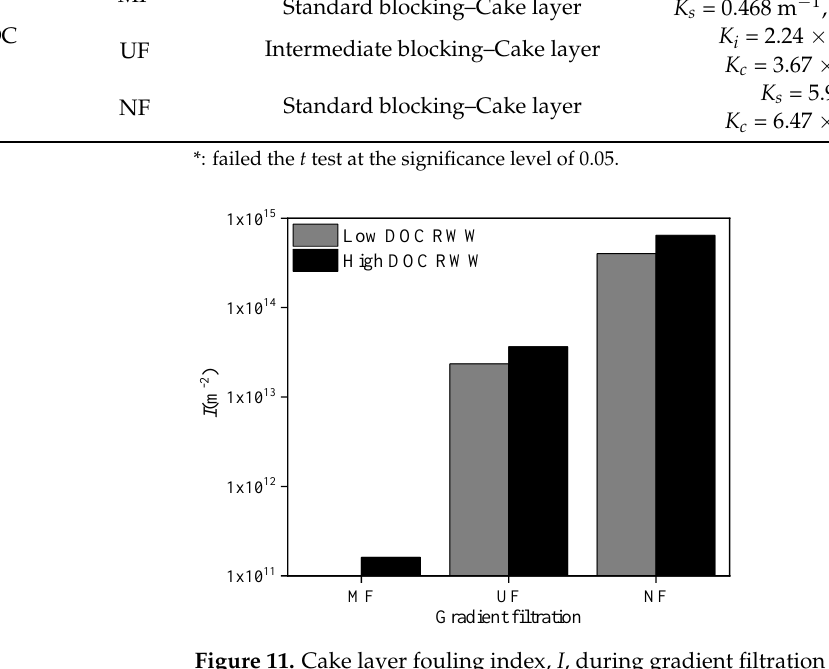
Figure 11 Cake layer fouling index, I, during gradient filtration of RWW. Figure 11. Cake layer fouling index, I , during gradient filtration of